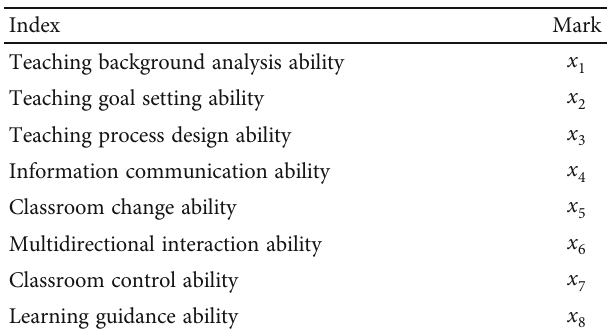
Table 1: Teaching ability evaluation